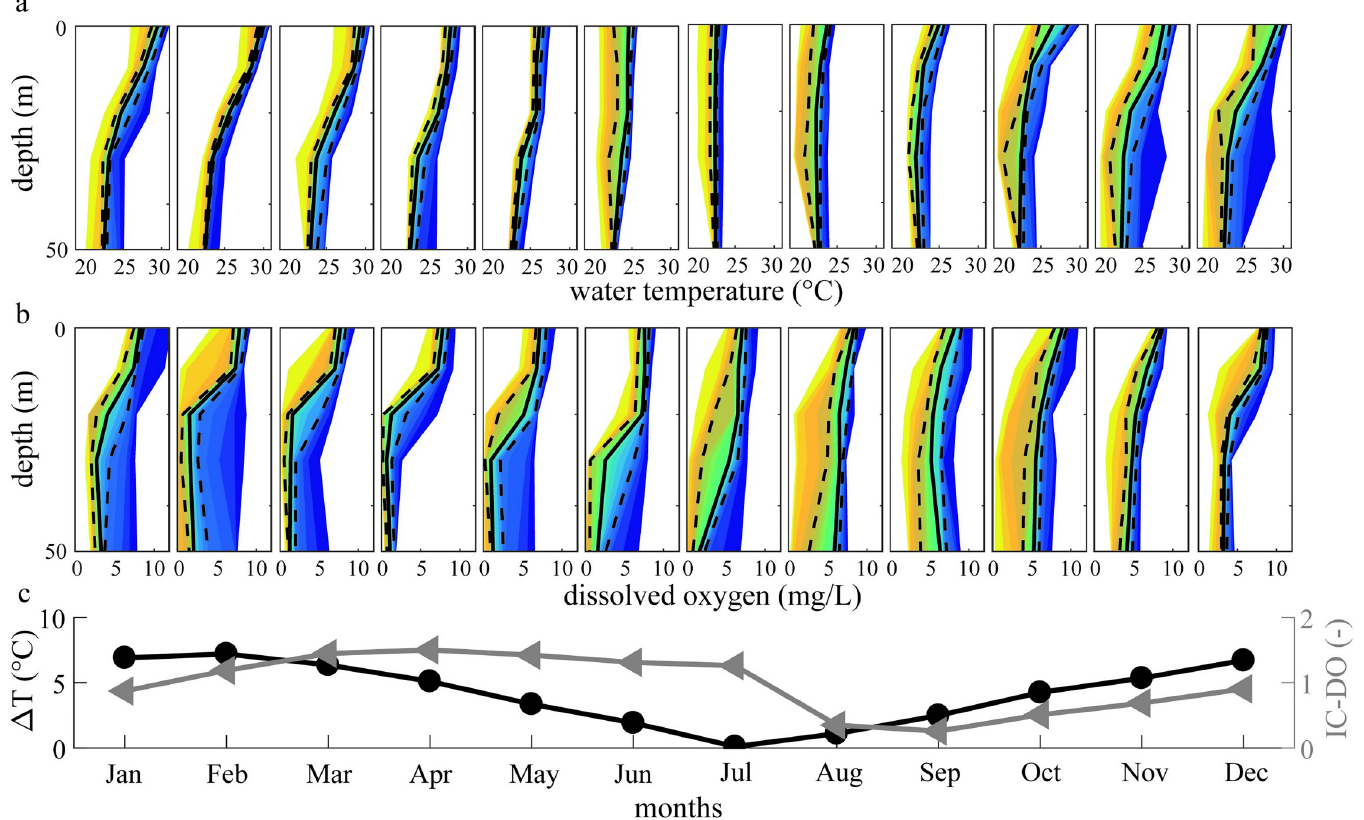
Fig 8. Monthly (a) lake water temperature and (b) dissolved oxygen variability. Solid black lines represent medians, dashed lines represent 25 th and 75 th percentiles, and the different colours represent the percentiles from 5 th to 95 th with a step of 5%. (c) Monthly stratification coefficients for water temperature (black dots) and dissolved oxygen (grey triangles) for each month of the year, using the temperature difference (˚C) between the upper- and the lowermost 5 m layer of the median thermal profiles and the IC-DO of each month.